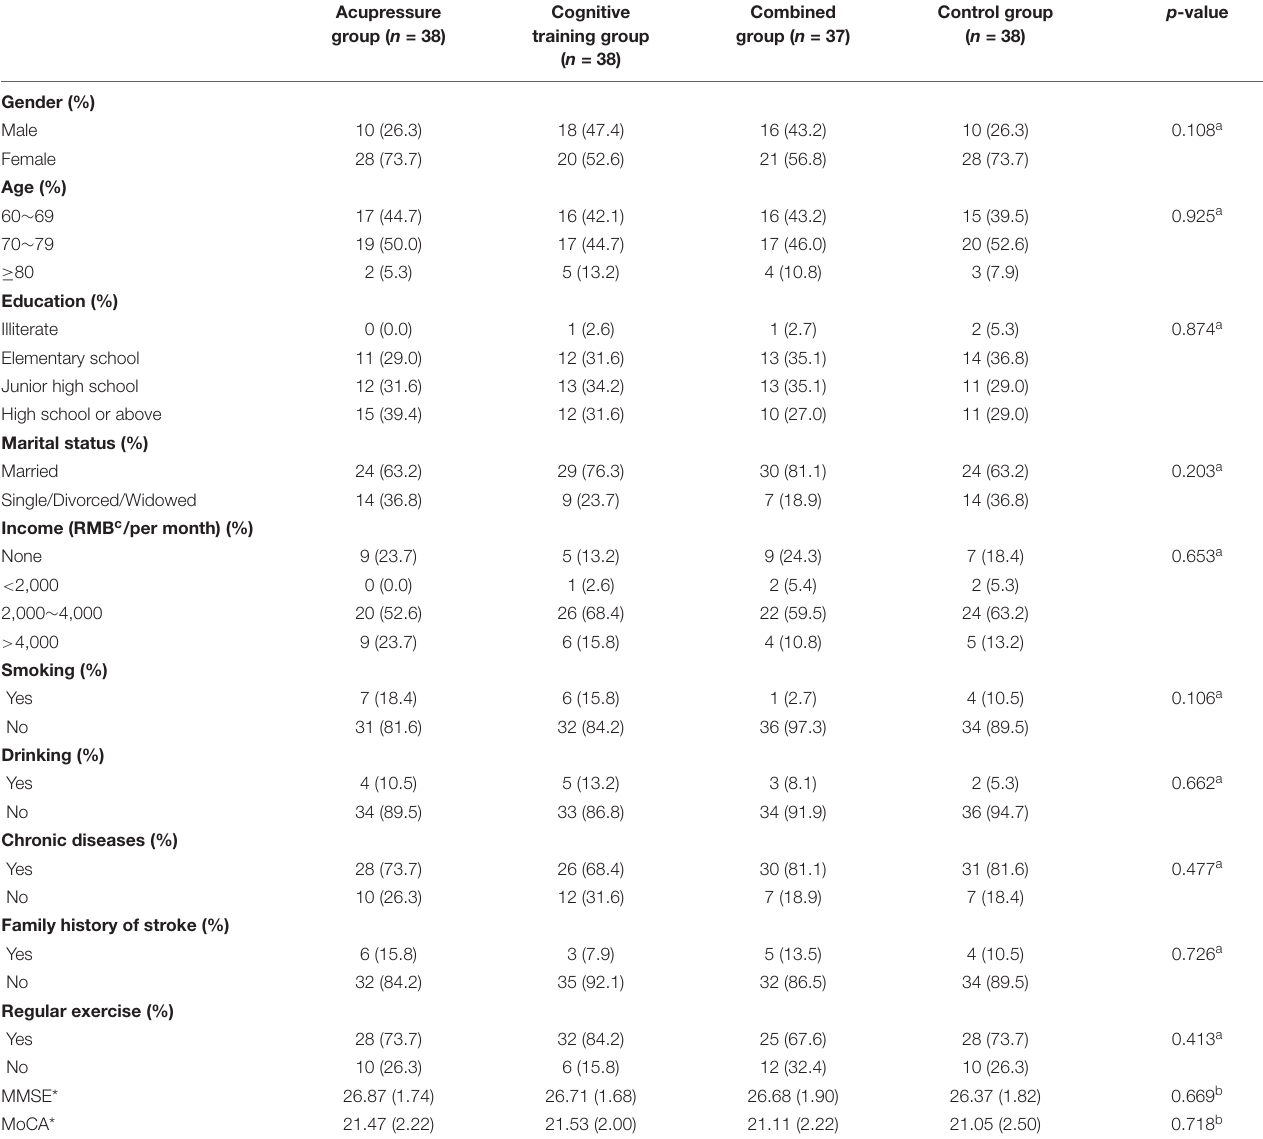
TABLE 2 | Basic demographical parameters and baseline characteristics of study population.